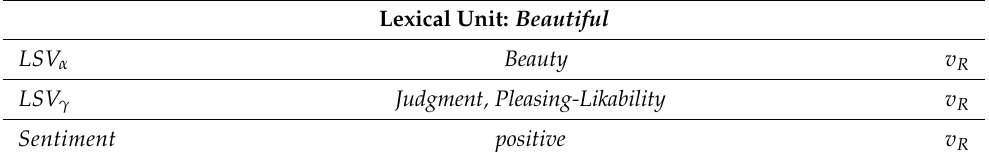
Table 3. Example of a tagged lexical unit. Lexical Unit: Beautiful LSV α Beauty v R Judgment, Pleasing-Likability